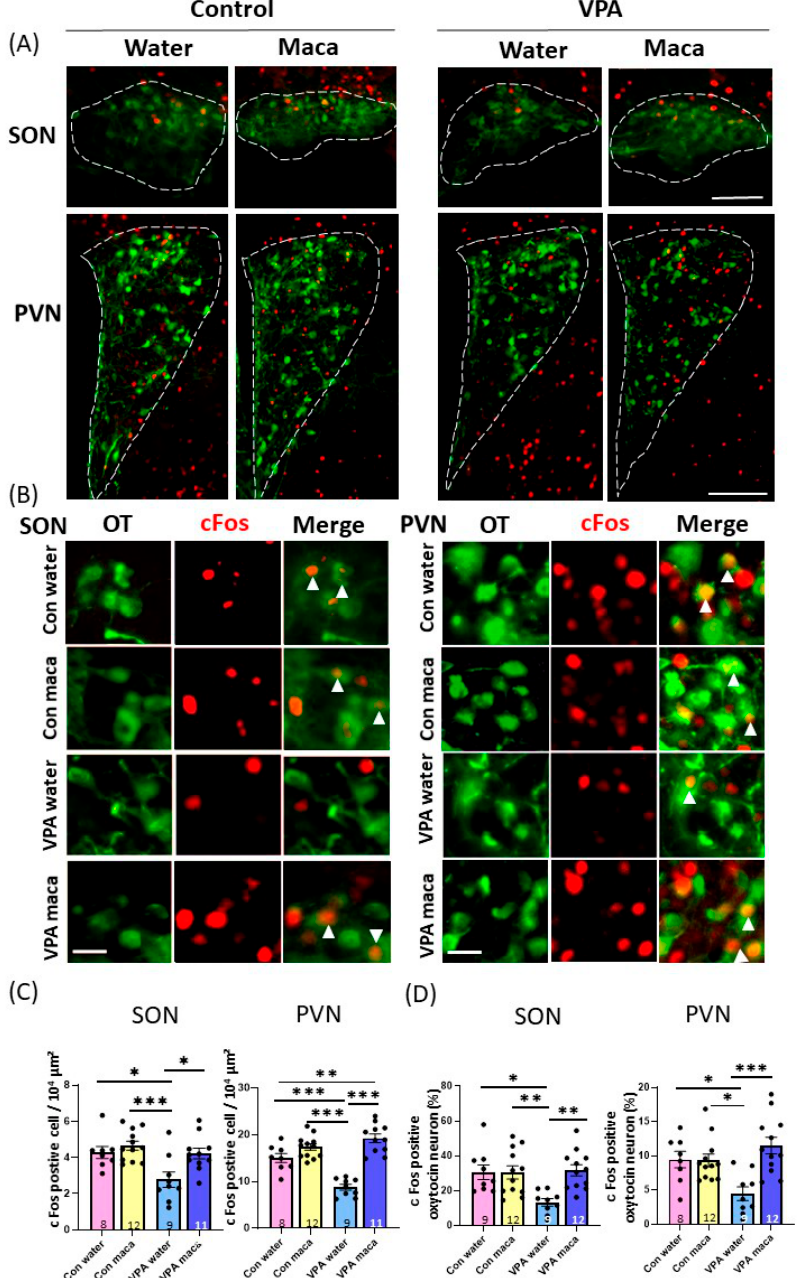
Figure 5. Induction of c-Fos in the supraoptic nucleus (SON) and paraventricular nucleus (PVN) of the hypothalamus after social interaction tests. ( A ) Representative merged immunostaining images in low OT magnification (green) and c-Fos (red) in the SON and PVN of control or VPA mice. The dotted areas are used for counting. Scale bars, 100 µ m. ( B ) Representative immunostaining images of OT (green, ( left )), c-Fos (red, ( middle )), and merge ( right ) in high magnification. Scale bars, 20 µ m. ( C ) The number of c-Fos-positive cells in the SON and PVN. ( D ) The percentage of c-Fos-expressing OT neurons. The percentages represent the number of c-Fos-positive OT neurons over the total number of OT neurons. The number of mice used for quantification in each group is indicated in the graph. The arrowhead shows representative c-Fos-positive OT neurons. * p < 0.05, ** p < 0.01, *** p < 0.001. Data are the mean ± SEM. Con: control. VPA: valproic